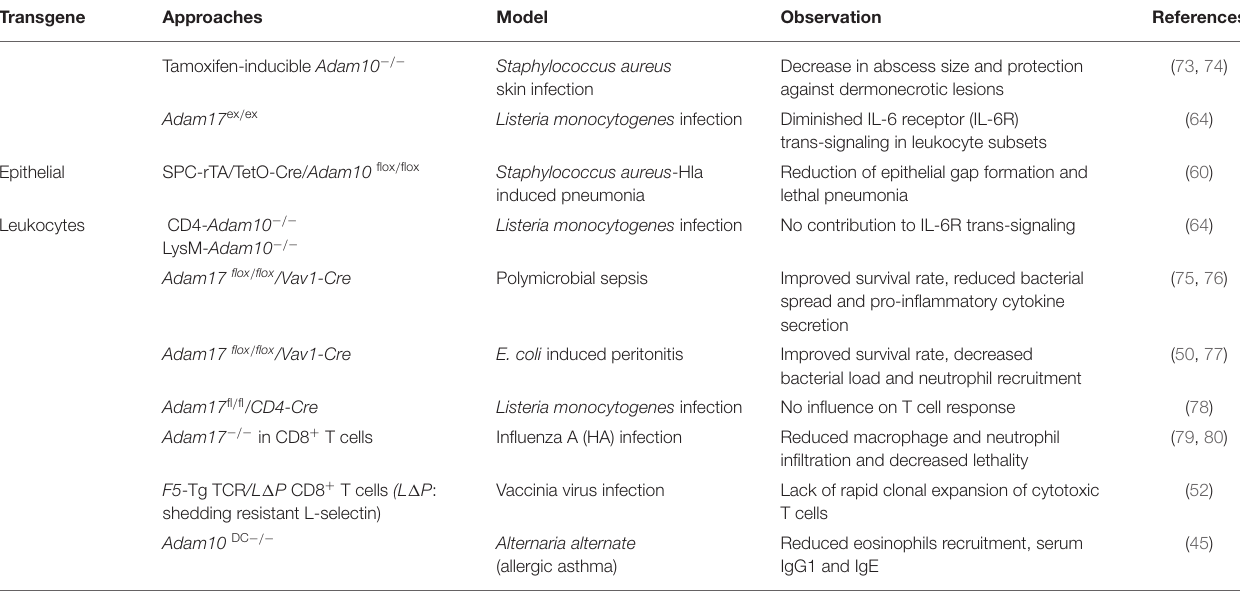
TABLE 2 | Infectious diseases in ADAM knockout animals.